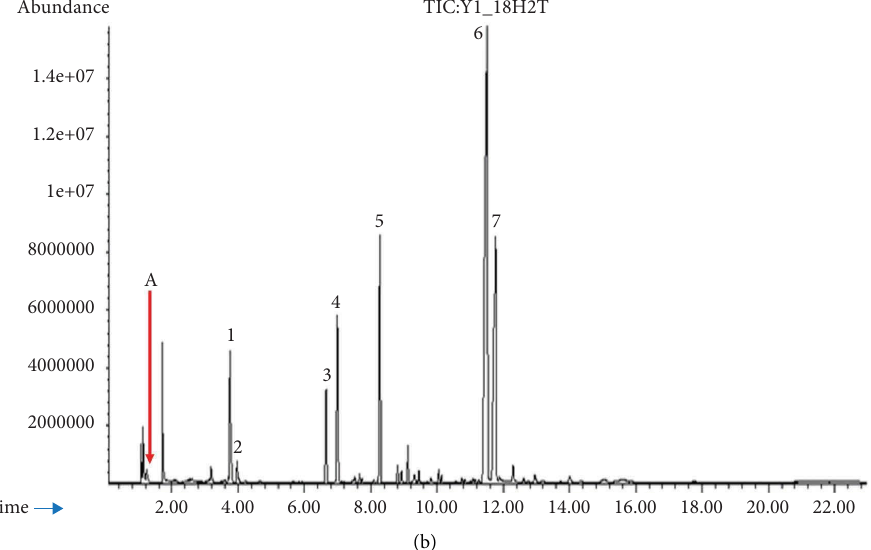
Figure 3: GC-MS chromatographic profles of seven selected terpenes in essential oils from the immature leaves at 0 − 6hrs (a) and 12 − 18 hrs (b) of hydrodistillation: (A) internal standard (100 μ g/mL thiophene), (1) camphor, (2) L-borneol, (3) silphiperfol-5-ene, (4) 7-epi- silphiperfol-5-ene, (5) caryophyllene, (6) ɤ -eudesmol, and (7) α